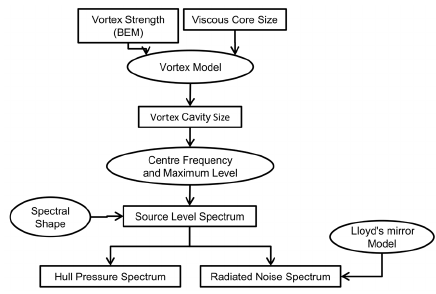
Figure 1. Flow chart of the Empirical Tip Vortex cavity (ETV) model for broadband hull pressure fluctuations and underwater radiated noise.